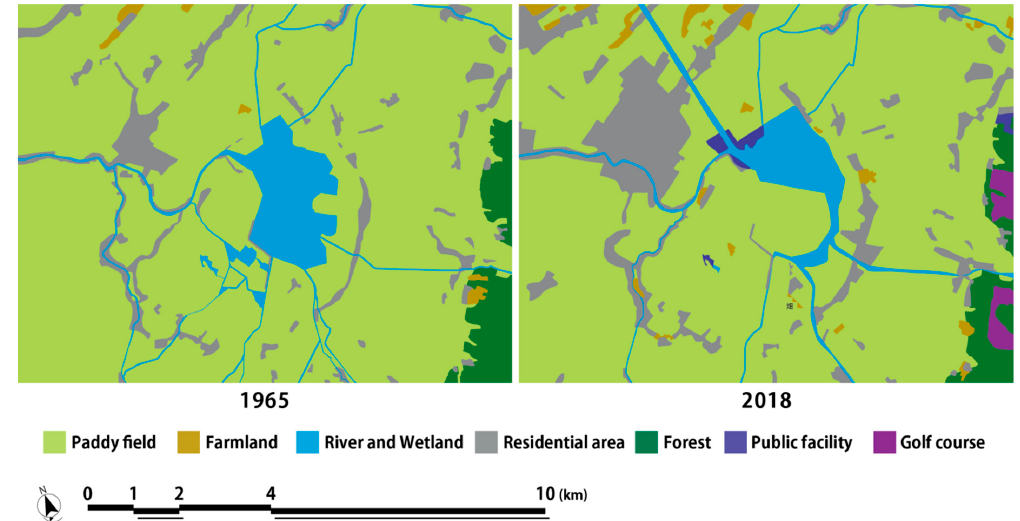
Figure 3. Land use around the Fukushima-gata lagoon. Based on the National Land Numeral Information Land Use Subdivision 100 m Mesh Data (2014) [6], clear figures were prepared using QGIS (Quantum GIS)